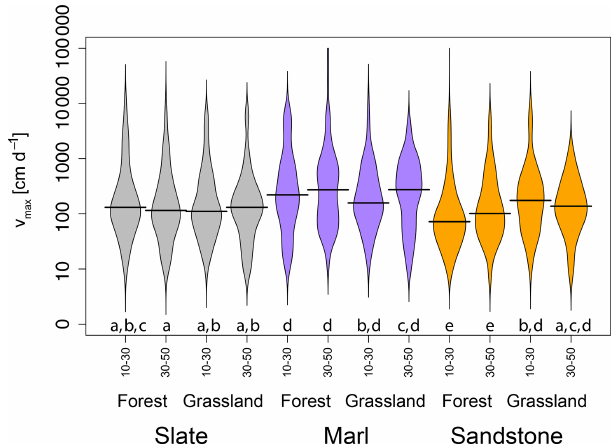
Figure 8. Violin plot of observed v max for the six landscape units (colors) and two depths (10–30, 30–50cm). Same letters below the plots symbolize no significant difference ( p < 0 . 025, Dunn test, two-sided, Benjamini–Hochberg